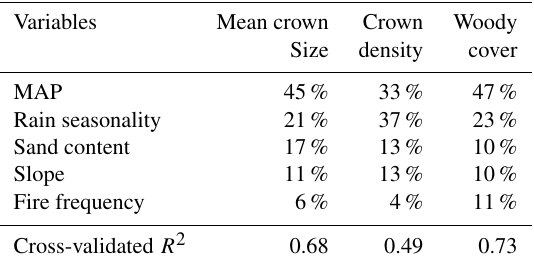
Table 1. Relative influence of each environmental variable and the cross-validated R 2 from the BRT models when modeling woody cover, crown density, and mean crown size.